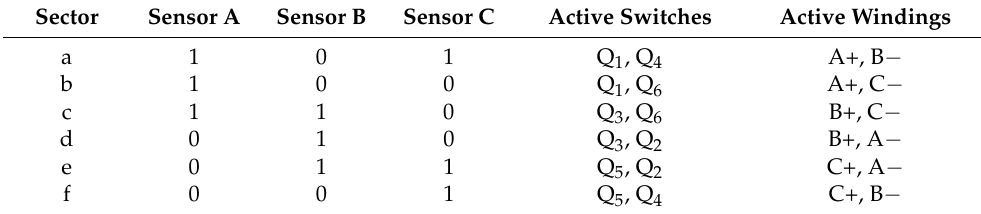
Table 1. The 120 ◦ commutation logic according to rotor position and the sensor